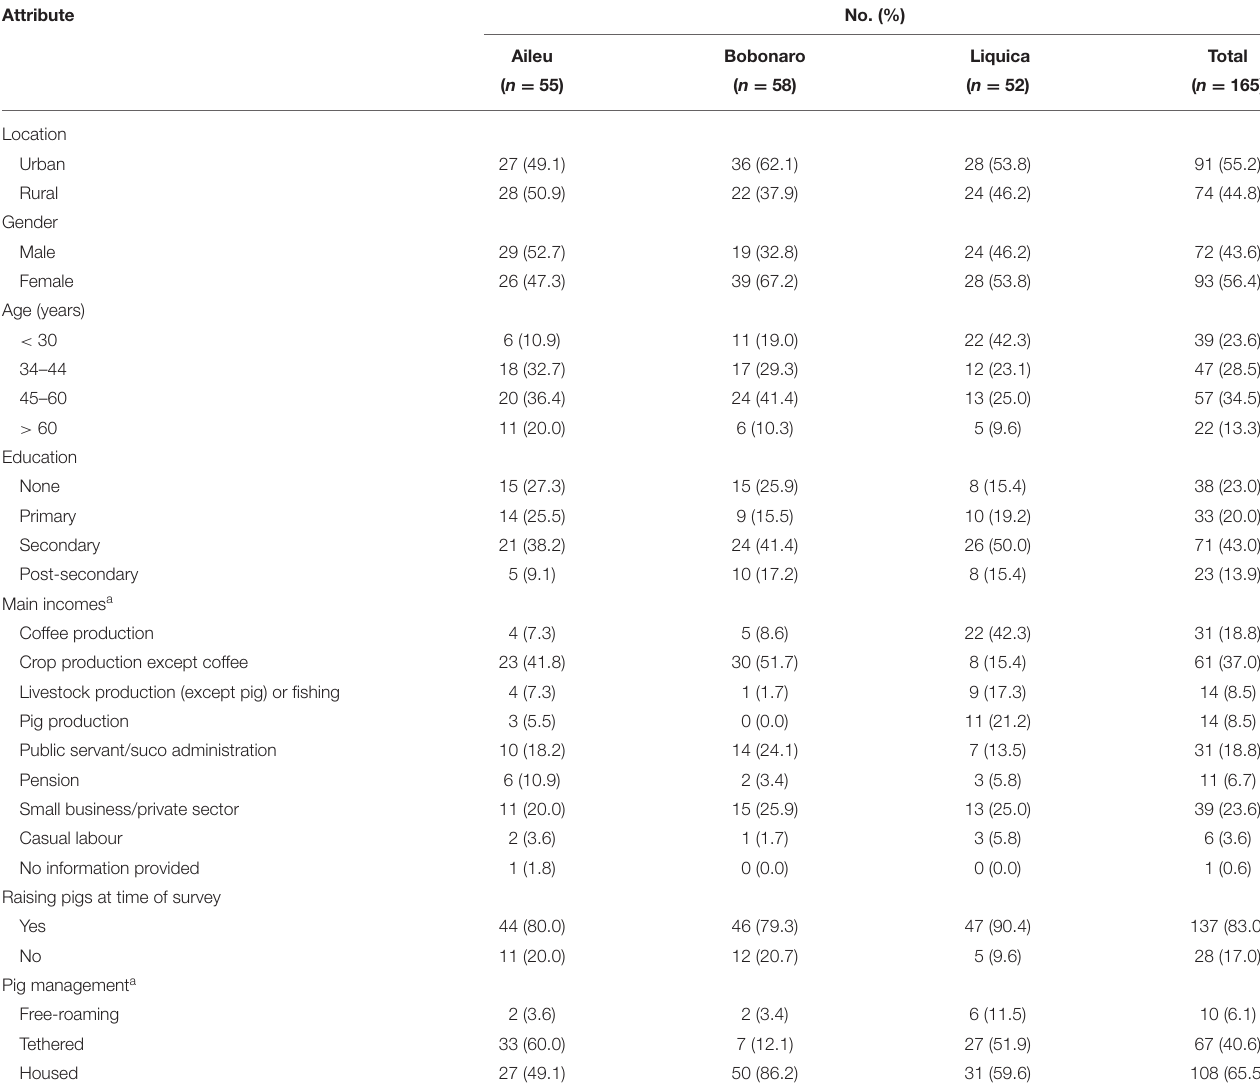
TABLE 1 | Demographic and pig raising information of 165 pig farmers (overall and by municipality) surveyed in Timor-Leste in 2020.